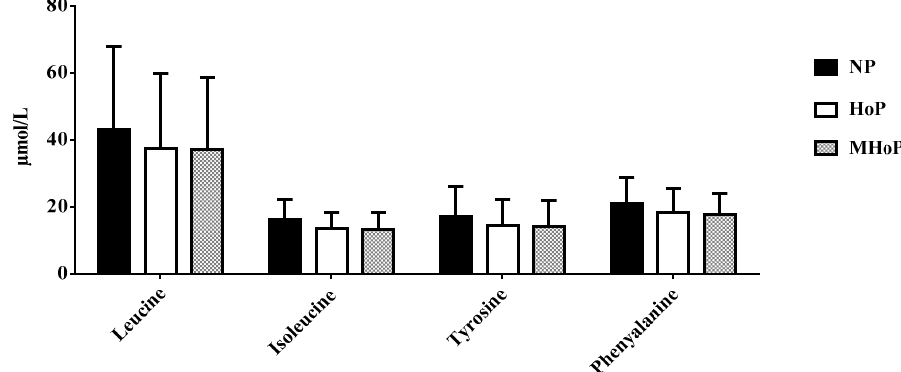
Figure 6. Amino acids concentration in not pasteurized, pasteurized by Holder method, and pasteurized by modified Holder method aliquots. NP—not pasteurized; HoP—Holder pasteurization; MHoP—modified Holder pasteurization.